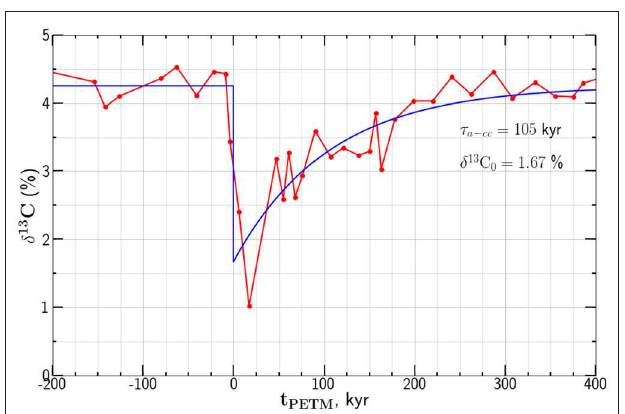
FIGURE 6 | Dependence of the atmosphere carbon mass values c M a for the PETM anomaly on time t PETM relative to the onset of the anomaly. The values are from our relaxation model give in Equation (11) with c M ab = 1,400 Gt and c M a 0 = 3,050